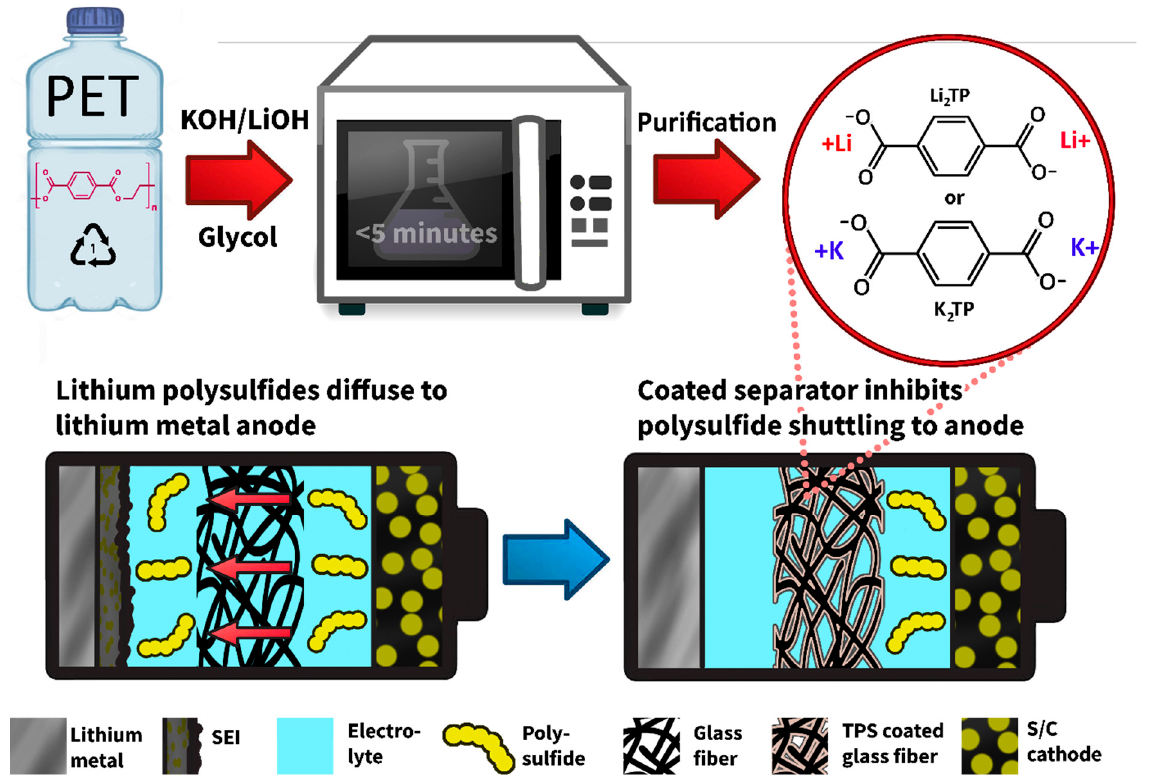
Figure 1. Pictorial of synthetic process of TPS from waste PET and LiPS blocking mechanism of the modified separator.